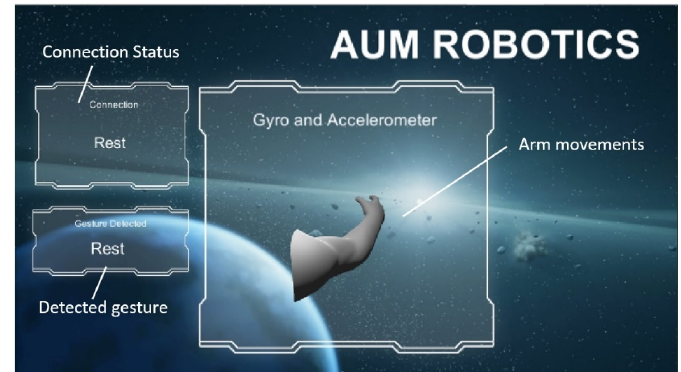
Figure 7. Interface screen on the PC with implemented graphical user interface